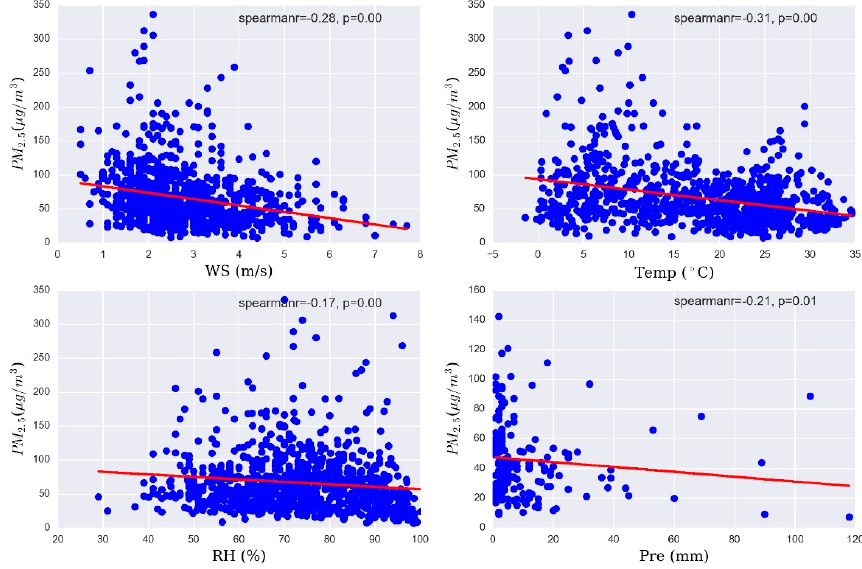
Figure 9. The relationship between PM 2.5 concentrations and meteorological conditions.